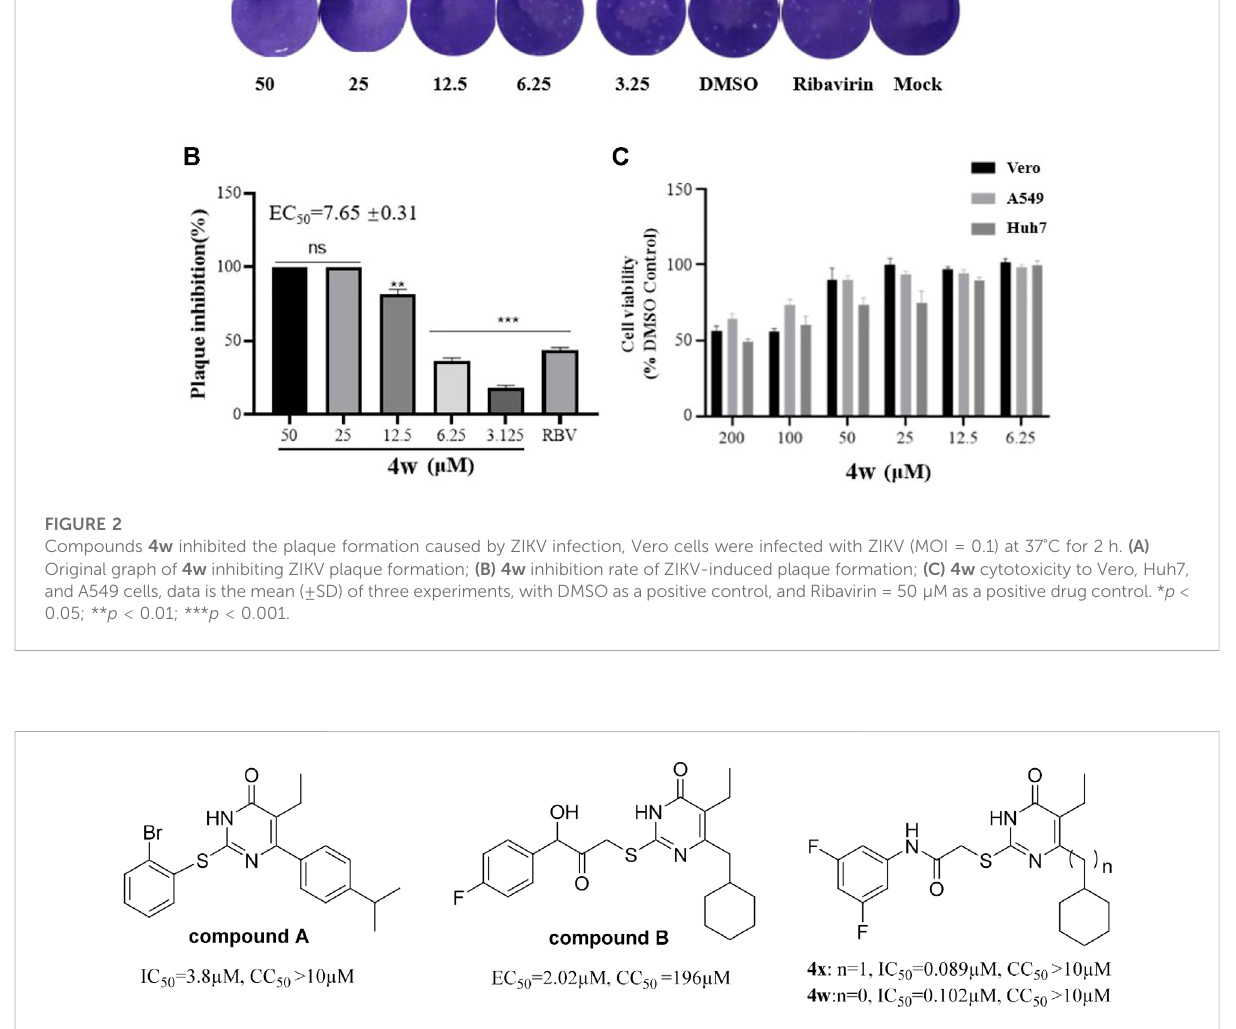
FIGURE 3 Pyrimidones analogues active against HCV targeting NS5B